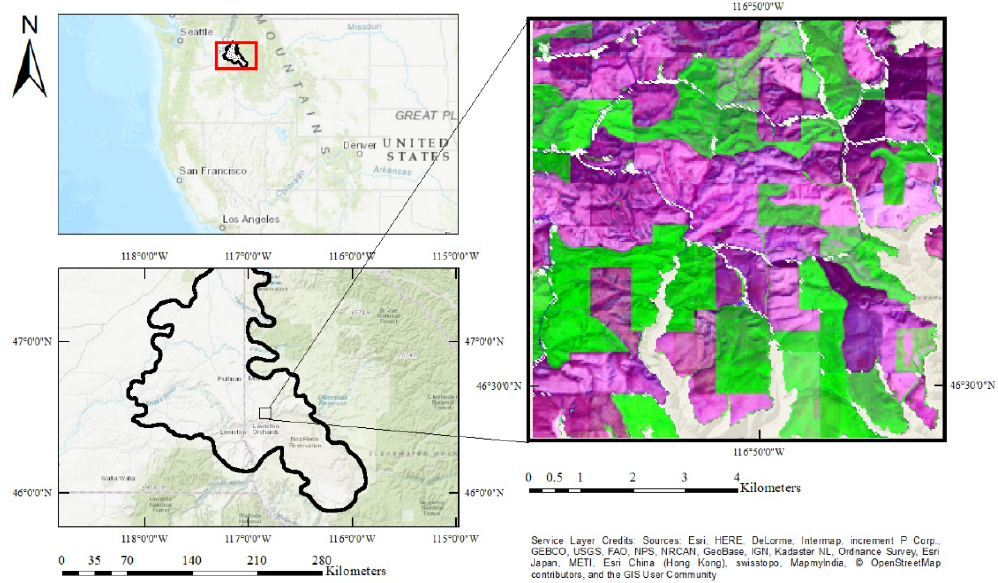
Figure 2. Location of the Palouse bioregion within the conterminous United States ( top left ) and location 8 km by 8 km study area within the Palouse bioregion ( bottom left ). Biophysical and top of canopy spectral data were collected from plots located in wheat, barley, and garbanzo fields ( right ). Sentinel-2 HLS product reflectances during early phenological stages for wheat, garbanzo, and barley on 2 May 2016, with crop mask, are used to provide geographic context and displayed as false color composition: R = SWIR 1.6 (1.57–1.65 µm), G = NIR (0.85–0.88 µm), and B = Blue (0.45–0.51 µm).